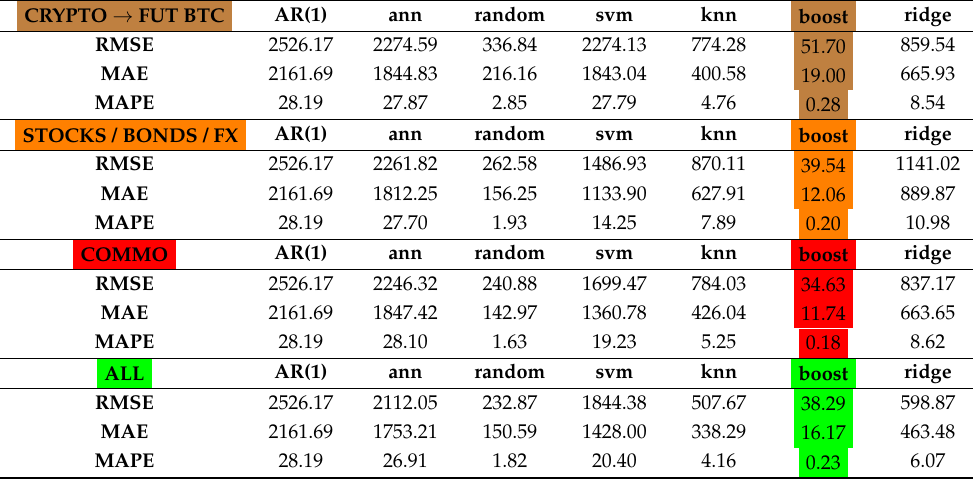
Table 11. Sub-sample forecasting results of CME Bitcoin Futures price during the year